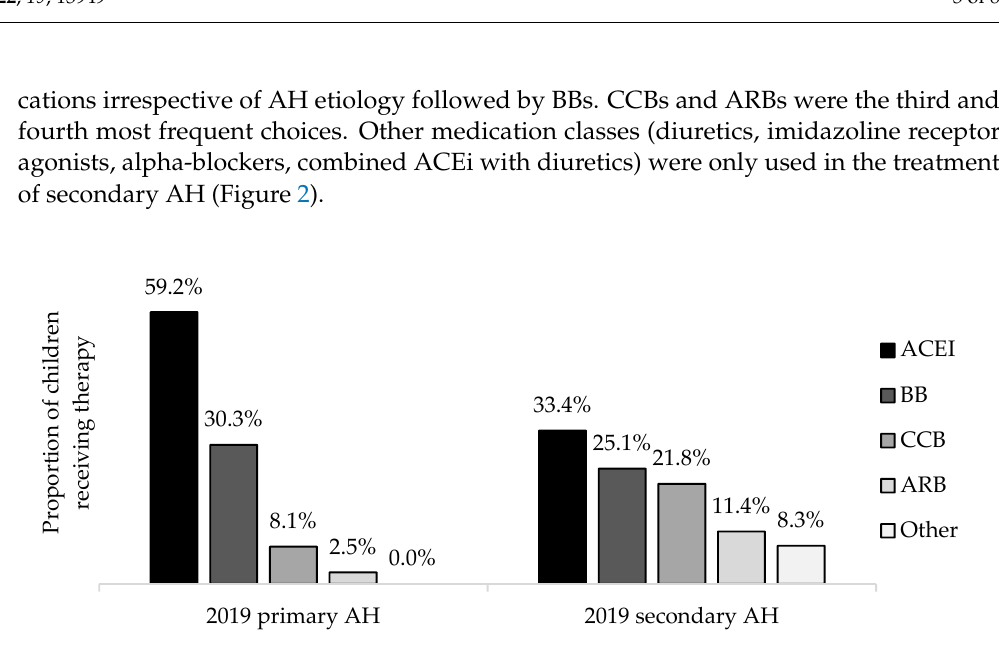
Figure 2. Distribution of drug classes used for the treatment by etiology of AH. Abbreviations: ACEi—angiotensin converting enzyme inhibitor, BB—beta blocker, CCB—calcium channel blocker, ARB—angiotensin receptor blocker.